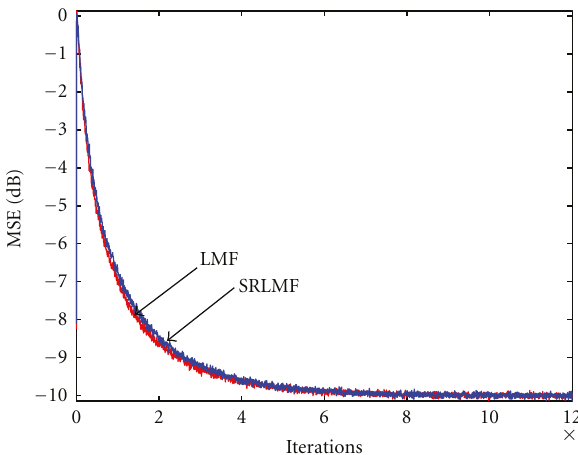
Figure 1: Comparison of the MSE learning curves of LMF and SRLMF algorithms in a uniform noise environment with SNR = 10dB.